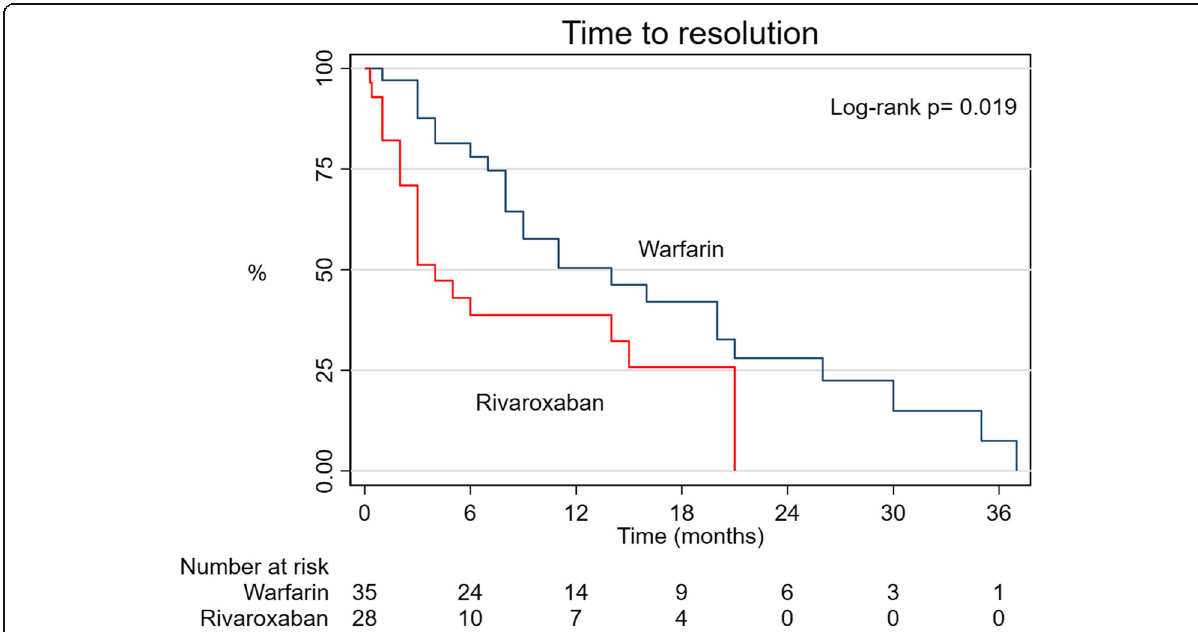
Fig. 2 Kaplan-Meier curve to time to resolution of the left ventricular thrombus in warfarin and rivaroxaban groups